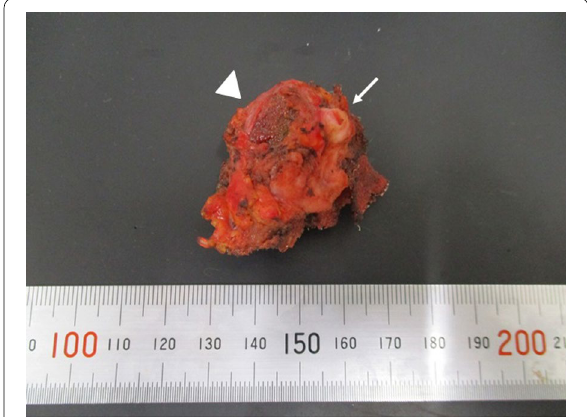
Fig. 4 Macroscopic findings of the abscess. Macroscopic examination shows a single mass containing the underlay mesh (arrowhead) and appendix